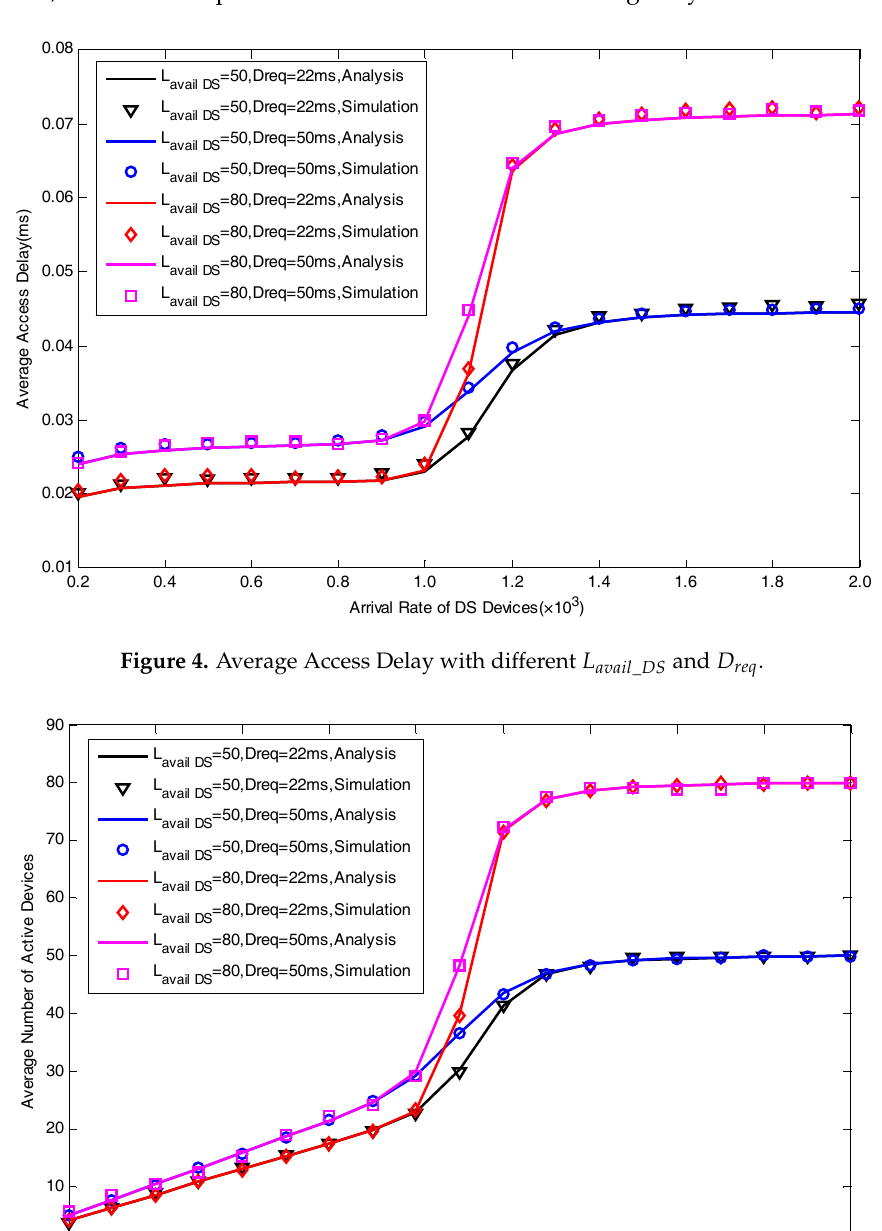
Figure 5. Average Number of Active Devices with different _ avail DS and .